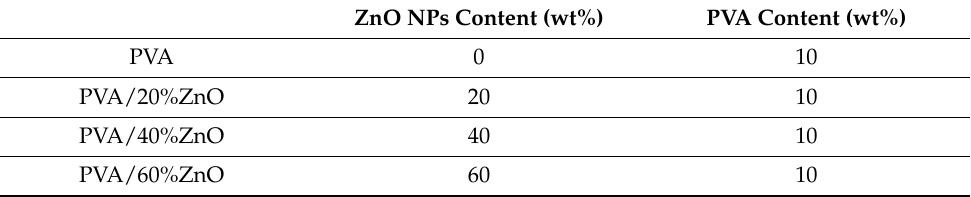
Table 1. Percentages of ZnO NPs and PVA of solutions prepared at different